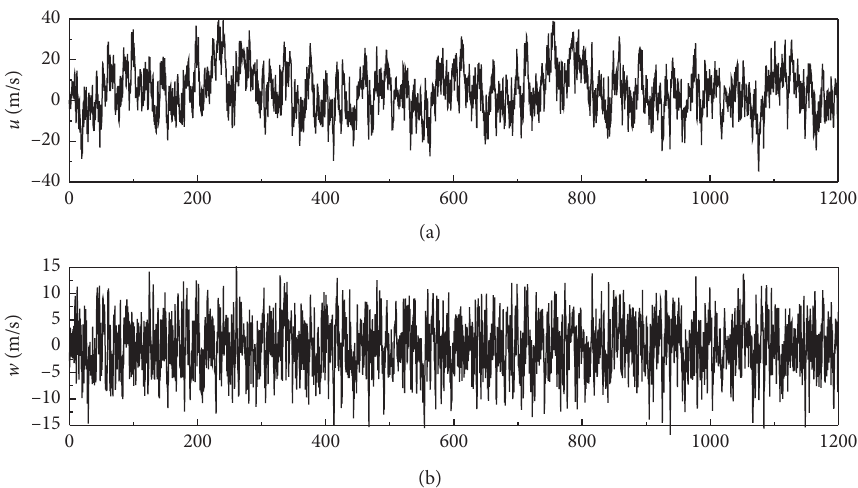
Figure 9: Time history of the simulated fluctuating wind at the midspan (#15) of Case 1: (a) longitudinal component; (b) vertical component.